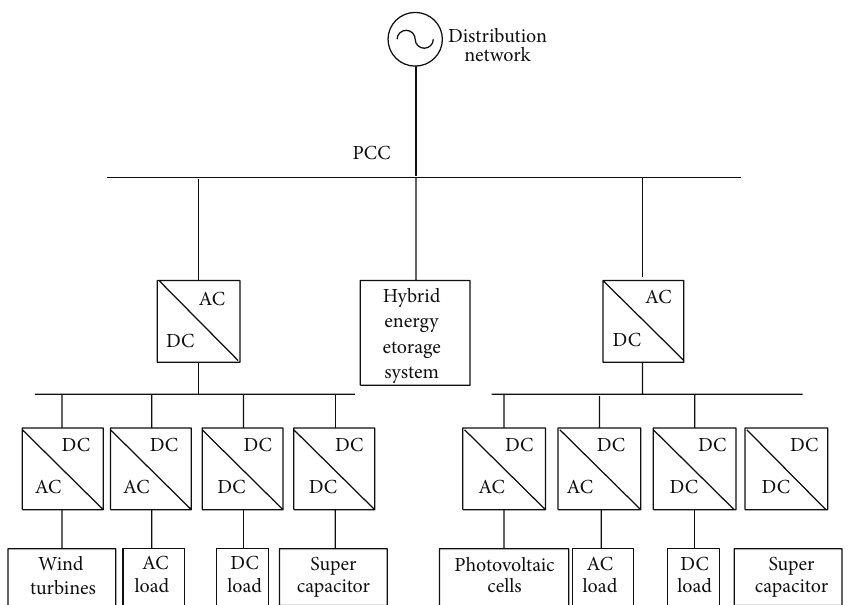
Figure 1. Different from the traditional topology, the designed microgrid is mainly composed of two sub-microgrids. Each sub-microgrid is essentially a DC microgrid, which contains a DG, a storage device, a DC load, and an AC load. The